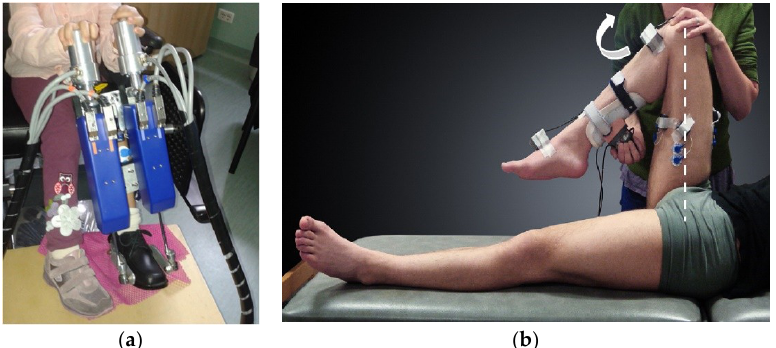
Figure 4. ( a ) Example of a motorized setup for stretching the ankle dorsi- and plantar flexors [32] and ( b ) a manual setup for extending the knee joint and stretching the flexor muscles [49].